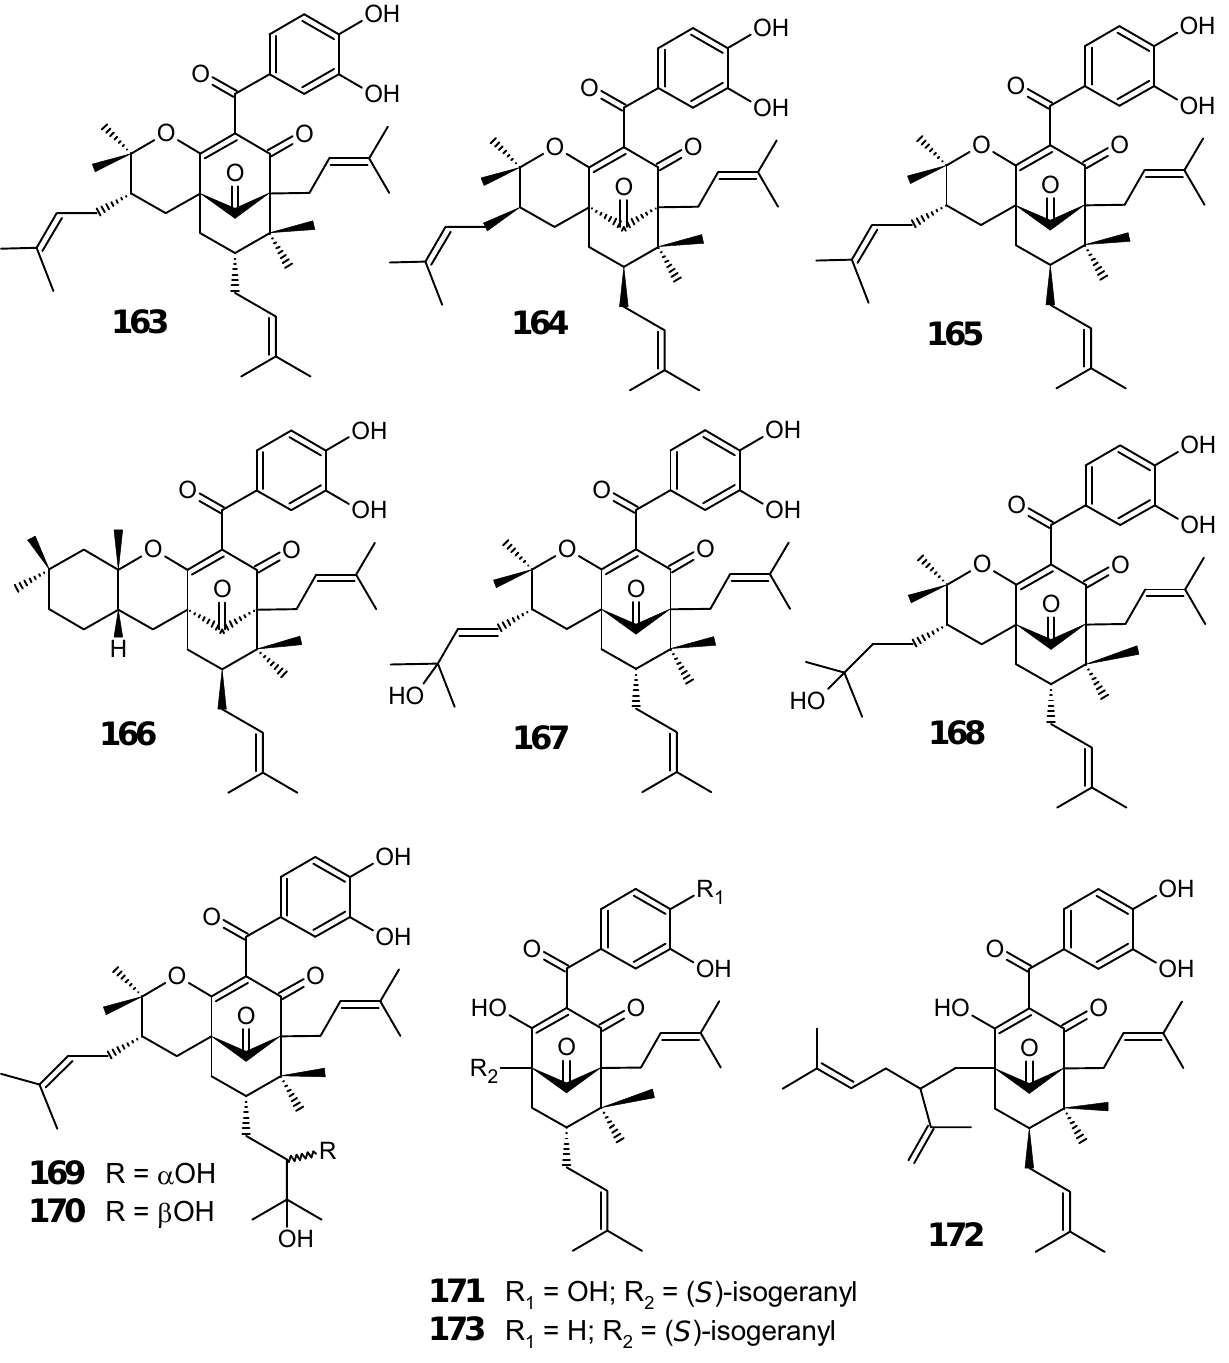
Figure 17. Antiplasmodial miscellaneous compounds 163-176